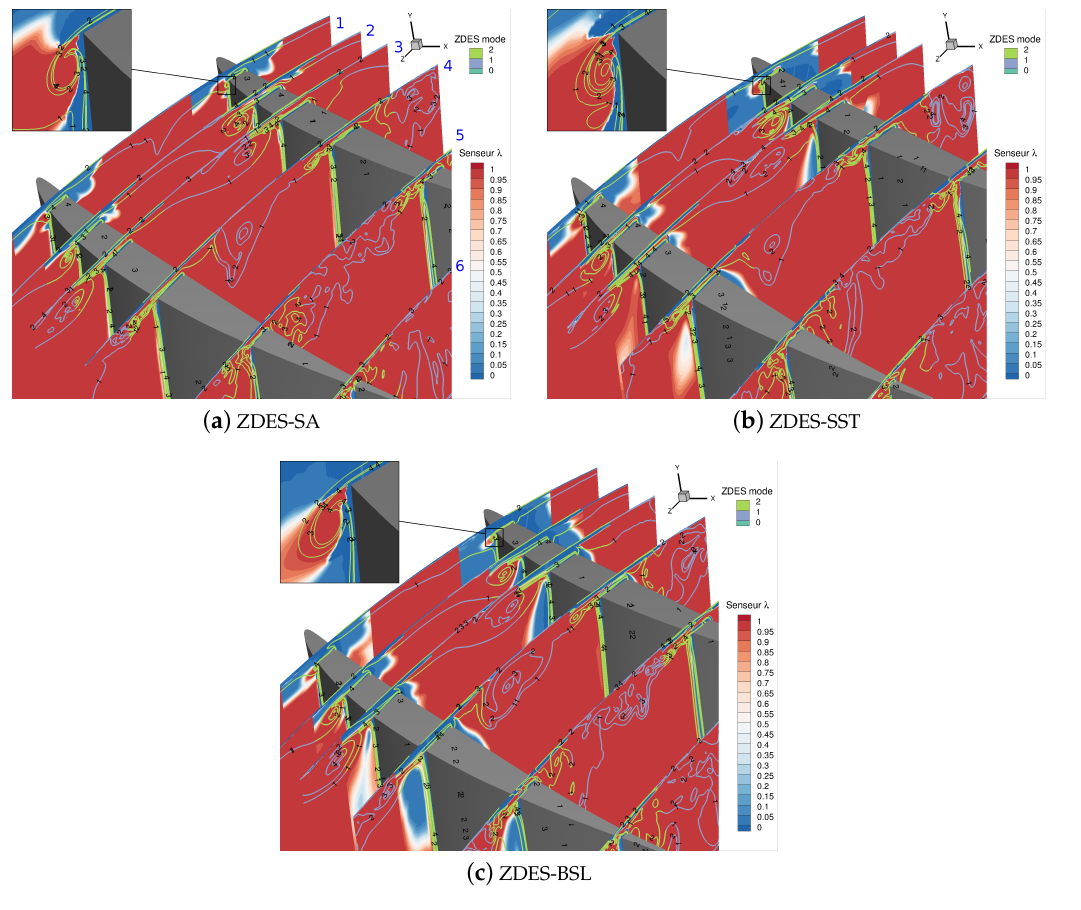
Figure 10. Contours of λ sensor in different axial planes near the rotor blade tip at the instant t = T /2 and isolines of entropy variation (to highlight the tip leakage vortex) colored by ZDES